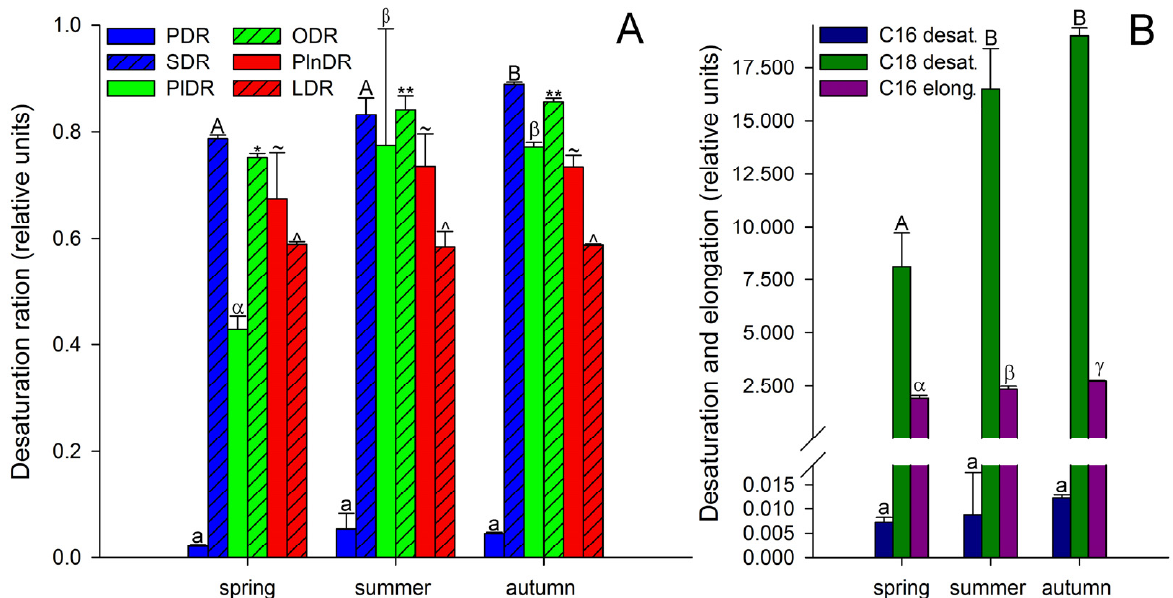
Figure 4. Desaturation ratios ( A ) and desaturation and elongation ( B ) of Asplenium scolopendrium fronds in spring, summer, and autumn. Abbreviations: PDR —palmitic desaturation ratio, and SDR —stearic desaturation ratio (the activity efficiencies of the Δ 9 desaturases); PlDR —palmitoleic desaturation ratio, and ODR —oleic desaturation ratio (the activity efficiencies of the ∆ 6 desaturases); PlnDR —palmitolinolenic desaturation ratio, and LDR —linoleic desaturation ratio (the activity efficiencies of the ∆ 3 desaturases); C16 desat. —C16 desaturation; C18 desat. —C18 desaturation; C16 elong. —C16 elongation ratio. Values are presented as the means ± SEMs. Different letters or symbols indicate a significant difference between the means ( p ≤ 0.05). One-way ANOVA, followed by Tukey’s HSD test, was performed separately for each parameter.